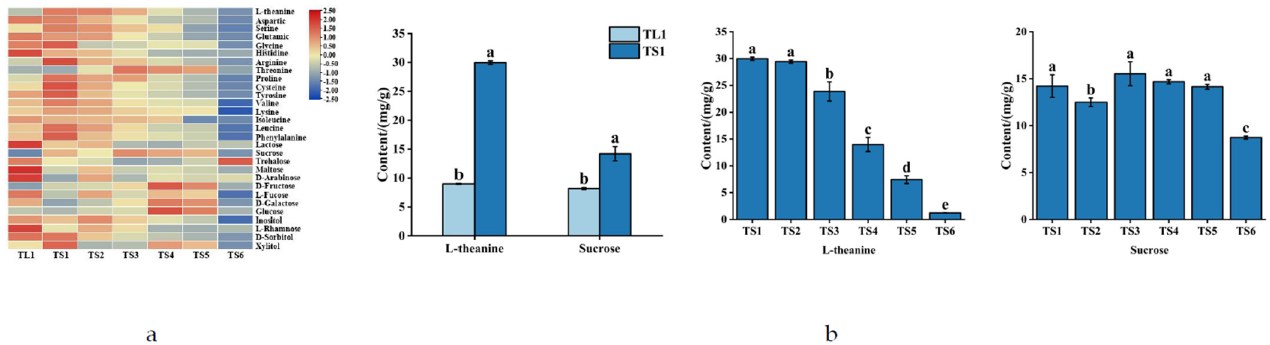
Figure 6. Free amino acids, monosaccharides, and disaccharides in tea leaves and stems. ( a ) Heatmap of free amino acids, monosaccharides, and disaccharides in tea leaves and stems; ( b ) L-theanine and sucrose in tea leaves and stems. Different superscript letters denote significant differences ( p <